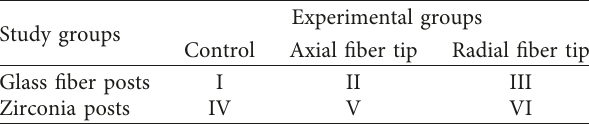
Table 1: General parameters of the studied